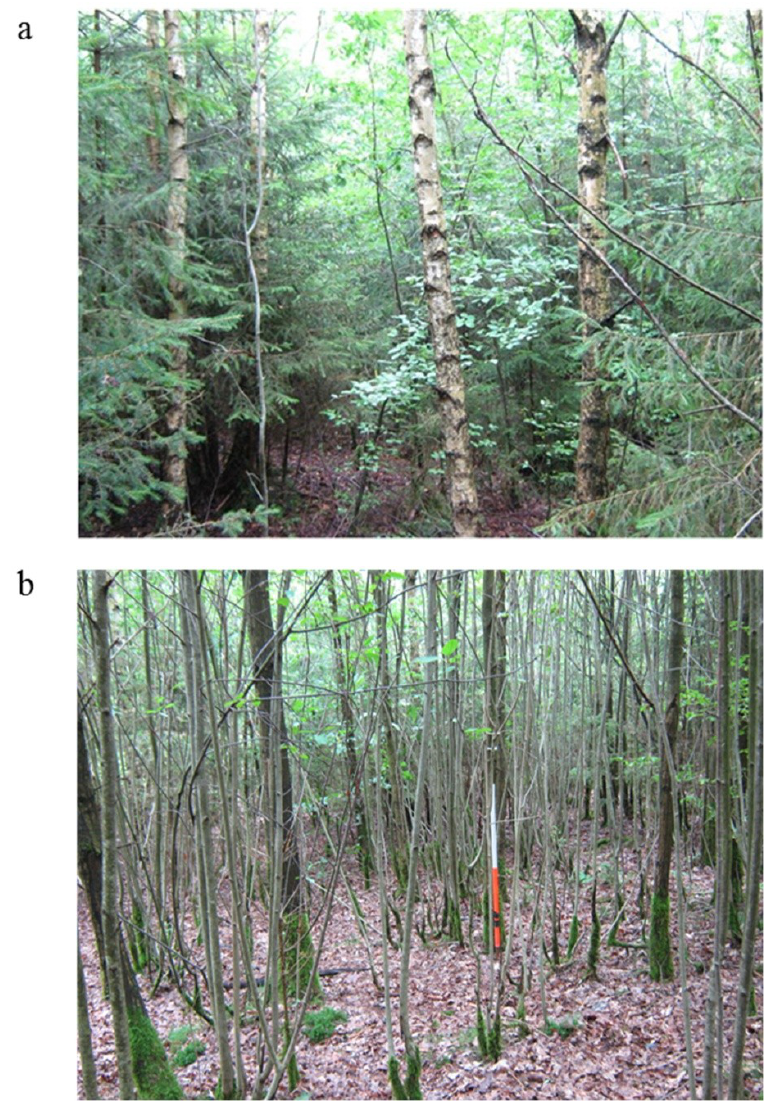
Figure 8. Natural regeneration of ( a ) Silver birch ( Betula pendula ) and Norway